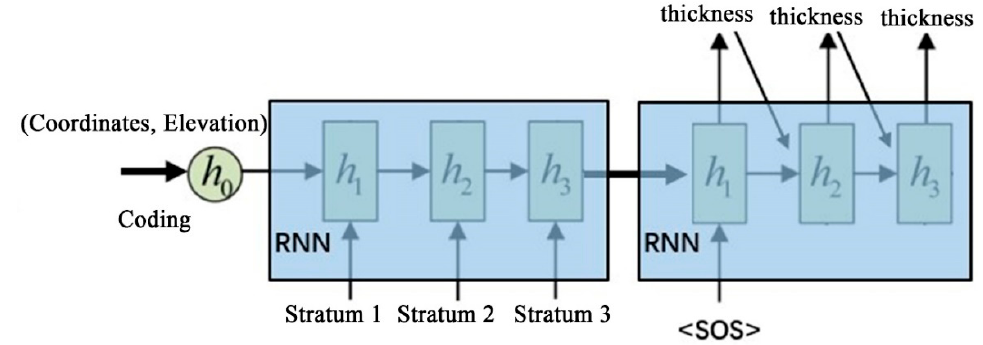
Figure 4. Structure diagram of the two-layer prediction network.